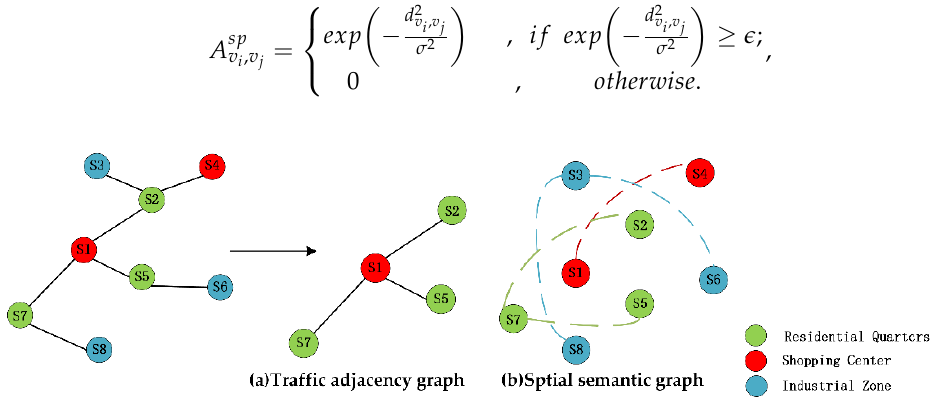
Figure 4. Traffic map construction: ( a ) Traffic spatial adjacency graph is structured according to traffic proximity. Regions geographically connected to region 𝑆1 (shopping center) are connected. ( b ) Global semantic adjacency graphs, where regions with similar functions have similar traffic patterns, are constructed to connect edges between regions with similar functions. For example, regions 𝑆2 , 𝑆6 and 𝑆8 are residential quarters, so they are connected.